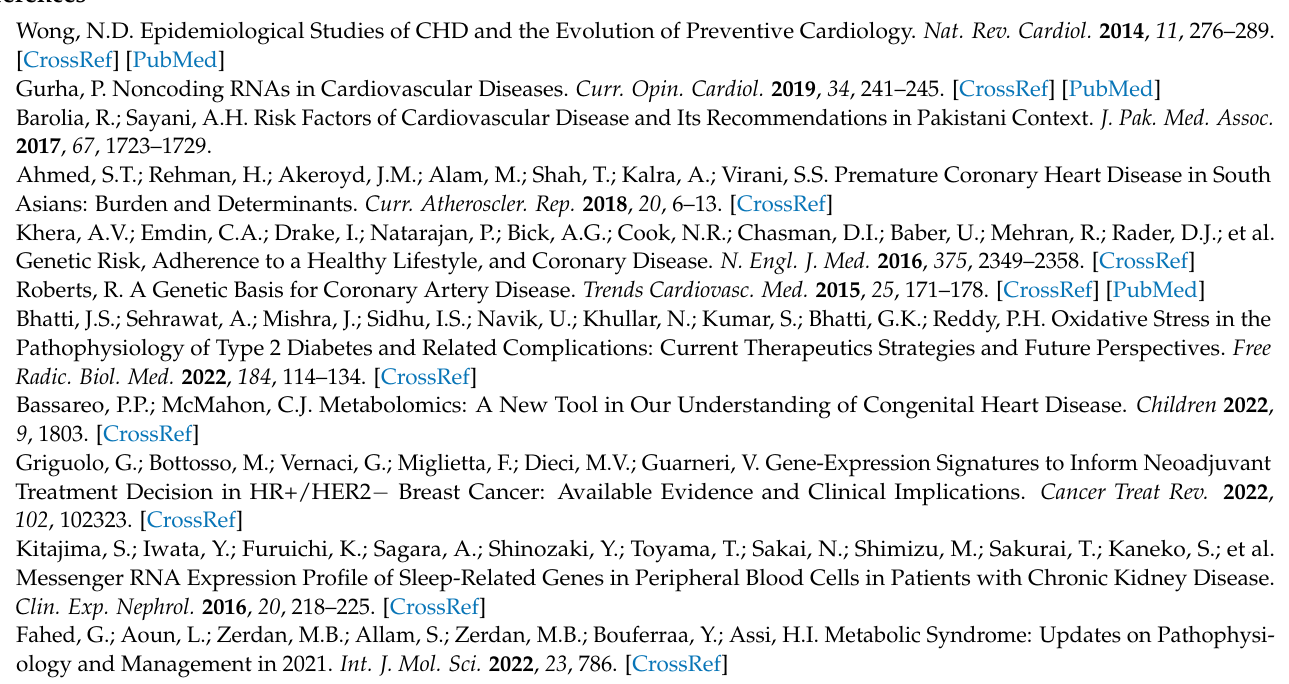
Table S2: list on miRNAs having more than 10 binding sites on circular; Table S3: Average fold changes of the cDEGs; Table S4: differentially expressed miRNA target genes; Table S5A–C: func- tional enrichment analysis for miR-DEGs of each of the miRN; Table S6: KEGG pathway analysis; Table S7: miRNAs and target gene homology; Table S8: Details of small molecules interacting with miRNAs; Figure S1: Details of miRNAs’ target DEGs; Figure S2: Detail of miR-DEGs in the regulation of JAK/STAT and Apelin signaling pathways; Figure S3: Details of mRNA-miRNA Hybrids. Author Contributions: M.R. performed the literature search, wrote the first draft of the manuscript, and made the data extraction and analysis. A.D., A.J., A.A.R. and H.M.A. participated in the analysis and interpretation of the data. M.J.K., A.L. and A.N. designed the work, supervised it, and